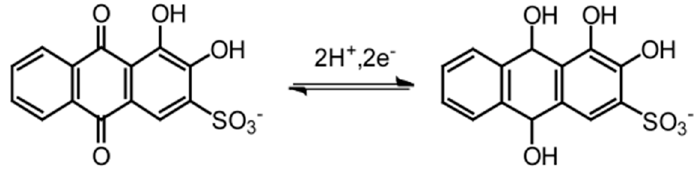
Figure 1. Redox reactions of ARS.